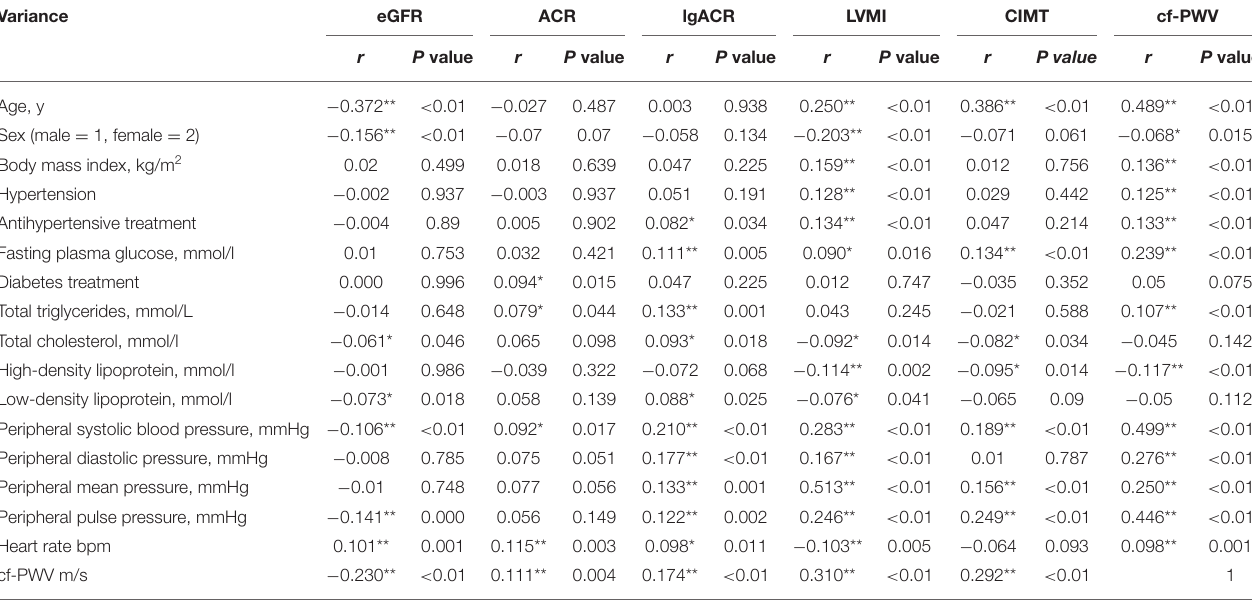
TABLE 3 | Correlation between asymptomatic hypertensive target organ damage and cardiovascular risk factors in hypertension. Variance eGFR